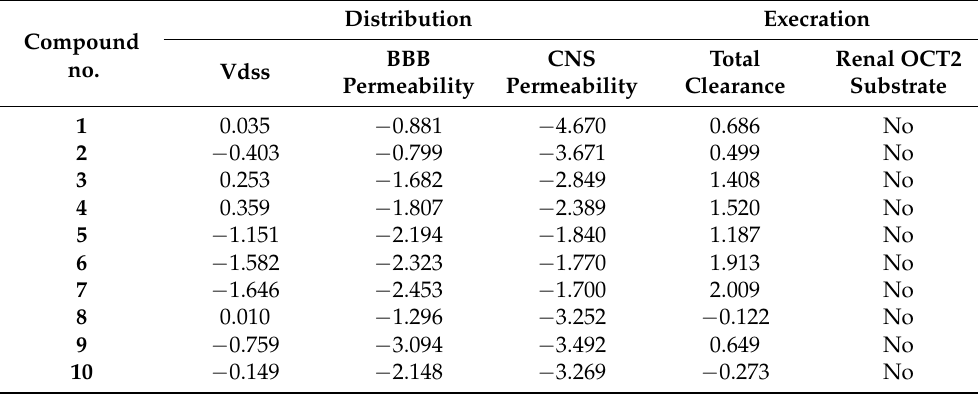
Table 7. Prediction in silico of distribution and execration of MGP